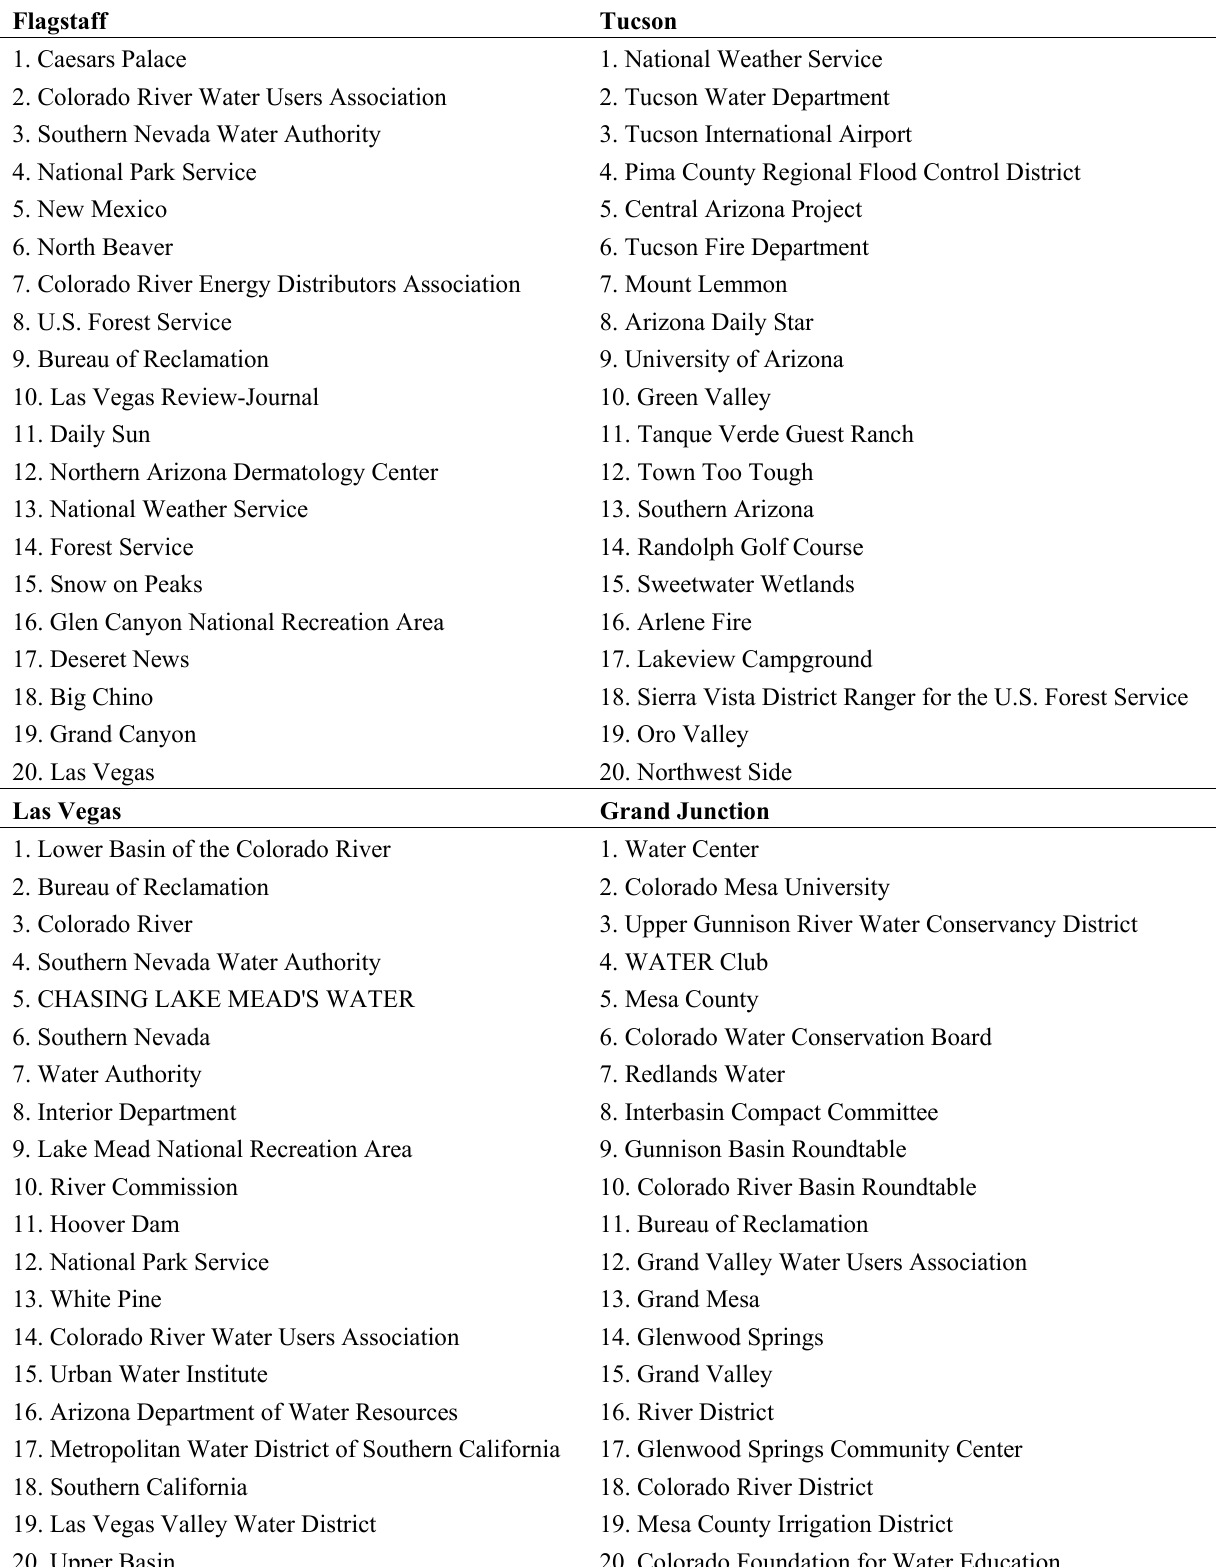
Table 7. Top 20 water-related institutions from the basic extraction algorithm.